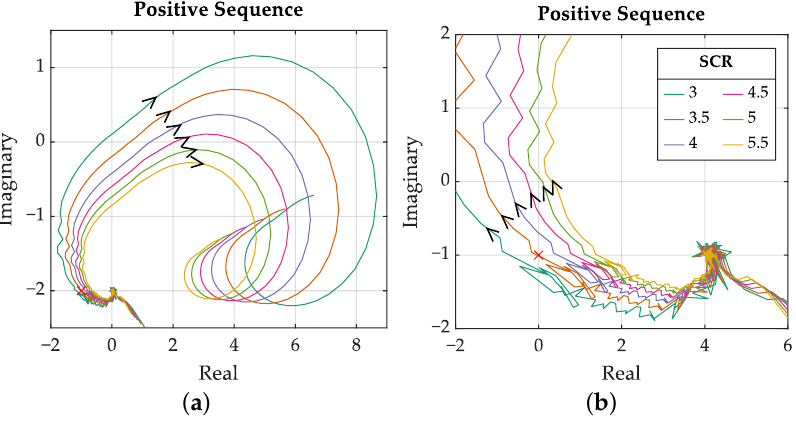
Figure 21. Complete (a) and zoomed (b) Nyquist plots of MMC in grid-following control mode and AC grid for different SCR with positive-sequence